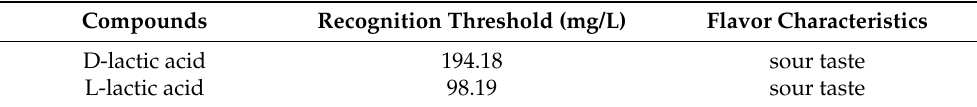
Table 4. Recognition thresholds and flavor characteristics of lactic acid enantiomers.